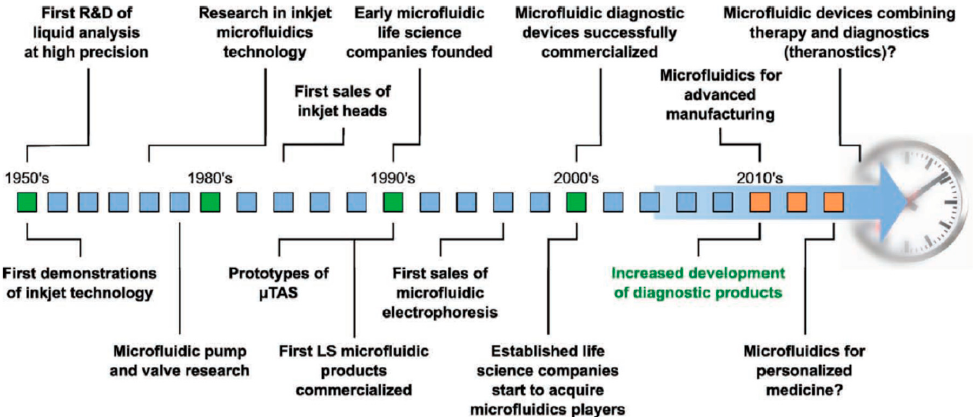
Figure 2. The timeline of the microfluidic technology evolution. Republished with permission from Gervais et al. [38].